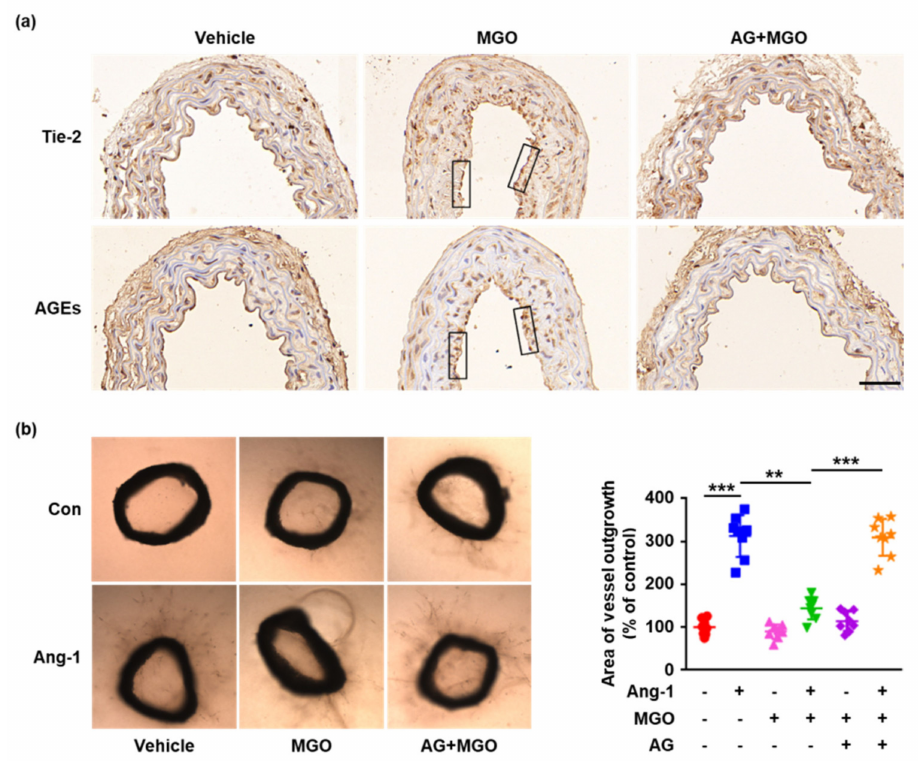
Figure 5. Glycation of Tie-2 inhibits Ang-1–induced vessel outgrowth ex vivo. The aortae derived from ND-fed C57BL/6J mice were isolated, treated with AG (100 µ M) or vehicle control for 1 h, followed by exposure to MGO (100 µ M) for 24 h. ( a ) The aortae were then fixed, embedded in paraffin, and sectioned. The Tie-2 and AGEs were immunohistochemically stained in two serial aortic sections. The solid black rectangles show the colocalization of Tie-2 and AGEs. Distance bars, 50 µ m. Representative images are shown. n ≥ 6 per group. ( b ) The aortic rings were embedded into collagen I gel and stimulated with Ang-1 (200 ng/mL) or vehicle control for 14 d. Representative images are shown. n = 8 per group. Quantitative analysis of microvessel sprouts from the aortic rings was carried out. ** p < 0.01, *** p < 0.001. Error bar represents the standard deviation and p value was generated by one-way ANOVA followed by post hoc